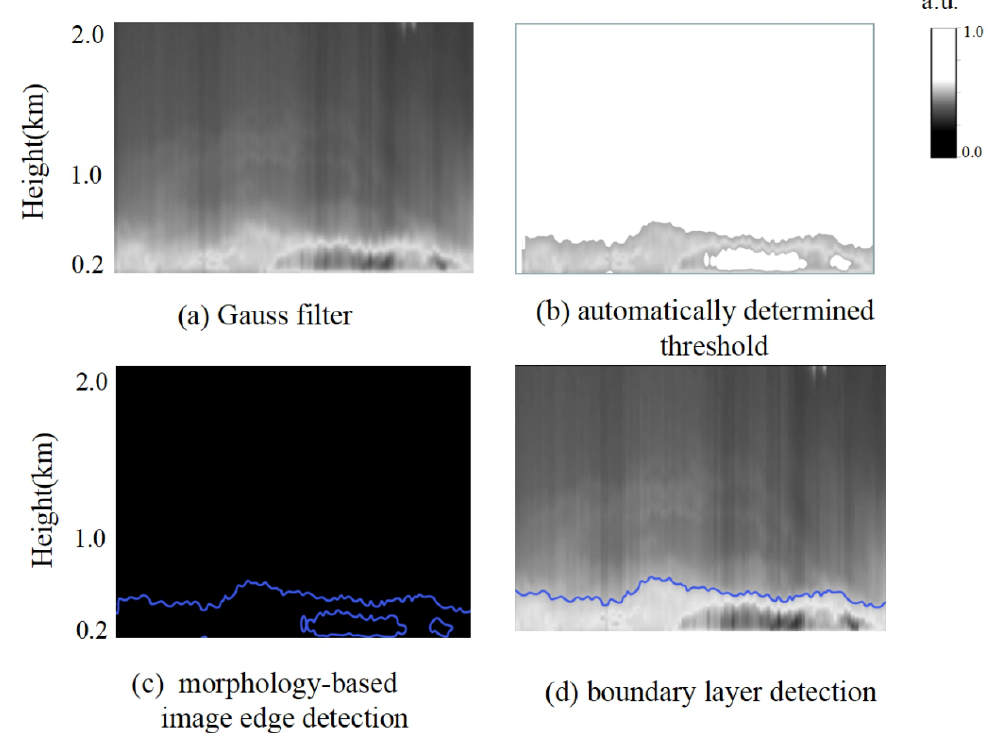
Figure 2. The processing steps of